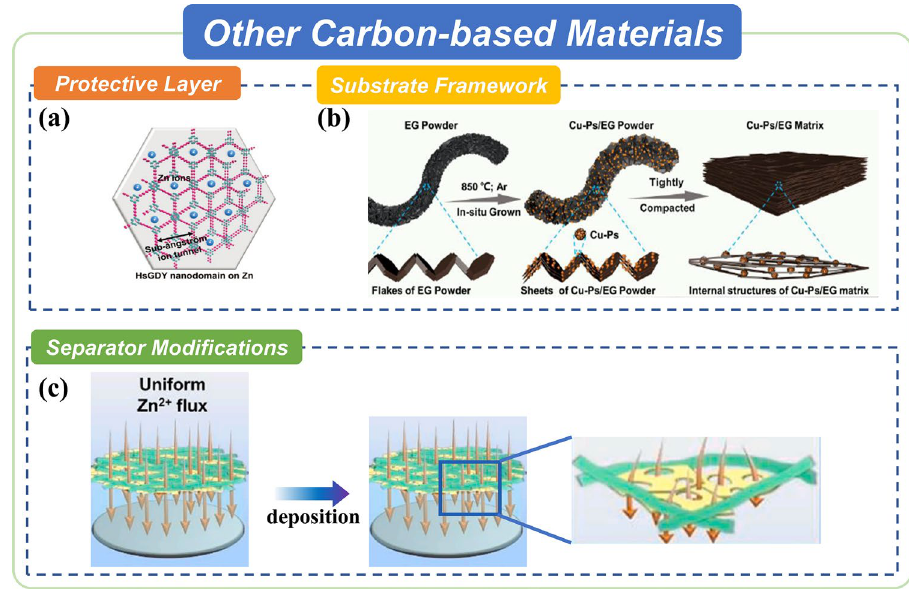
Fig. 5 Summary of other carbon-based 2D materials for advanced Zn anode. a Hydrogen-substituted graphdiyne ion tunnels directed concentra- tion redistribution. Copyright 2020, Wiley. b In-situ grown Cu particles on expanded graphite enabled dendrite-free and flexible Zn metal anode. Copyright 2022, Elsevier. c 2D porous g-C 3 N 4 nanosheets manipulated Zn smooth deposition. Copyright 2021,